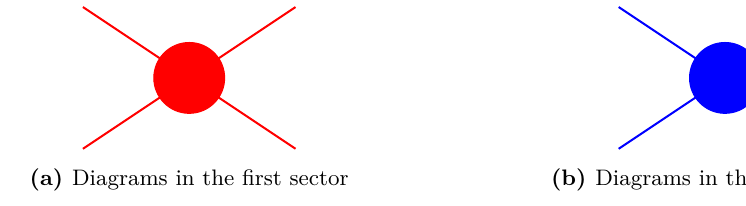
Figure 6. Diagrams without double trace vertices contributing to the vertex renormalizations of f 1 and f 2 : in both the diagrams, the pair of external legs on the left have the same color indices. Similarly, the pair of external legs on the right have the same color indices. The blobs contain only single trace vertices and propagators belonging to a particular